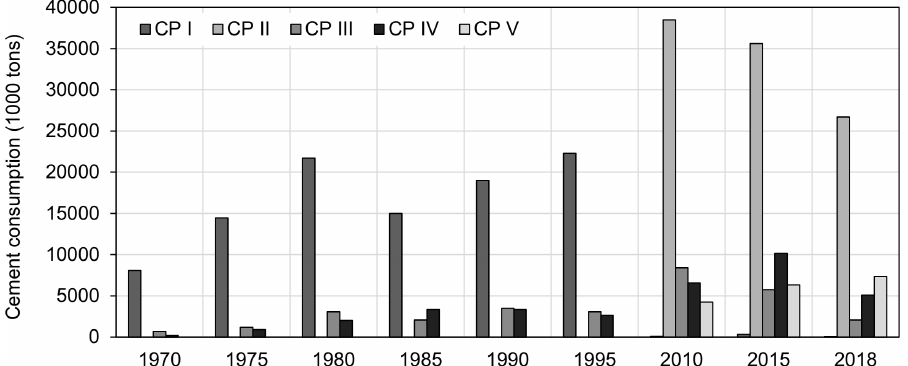
Figure 1. Brazilian consumption of Portland cement, by type. Note: the yearbooks of the 70s, 80s and 90s do not present values for CP V consumption, and there was no specification on the consumption of Portland cement in the years 2000 and